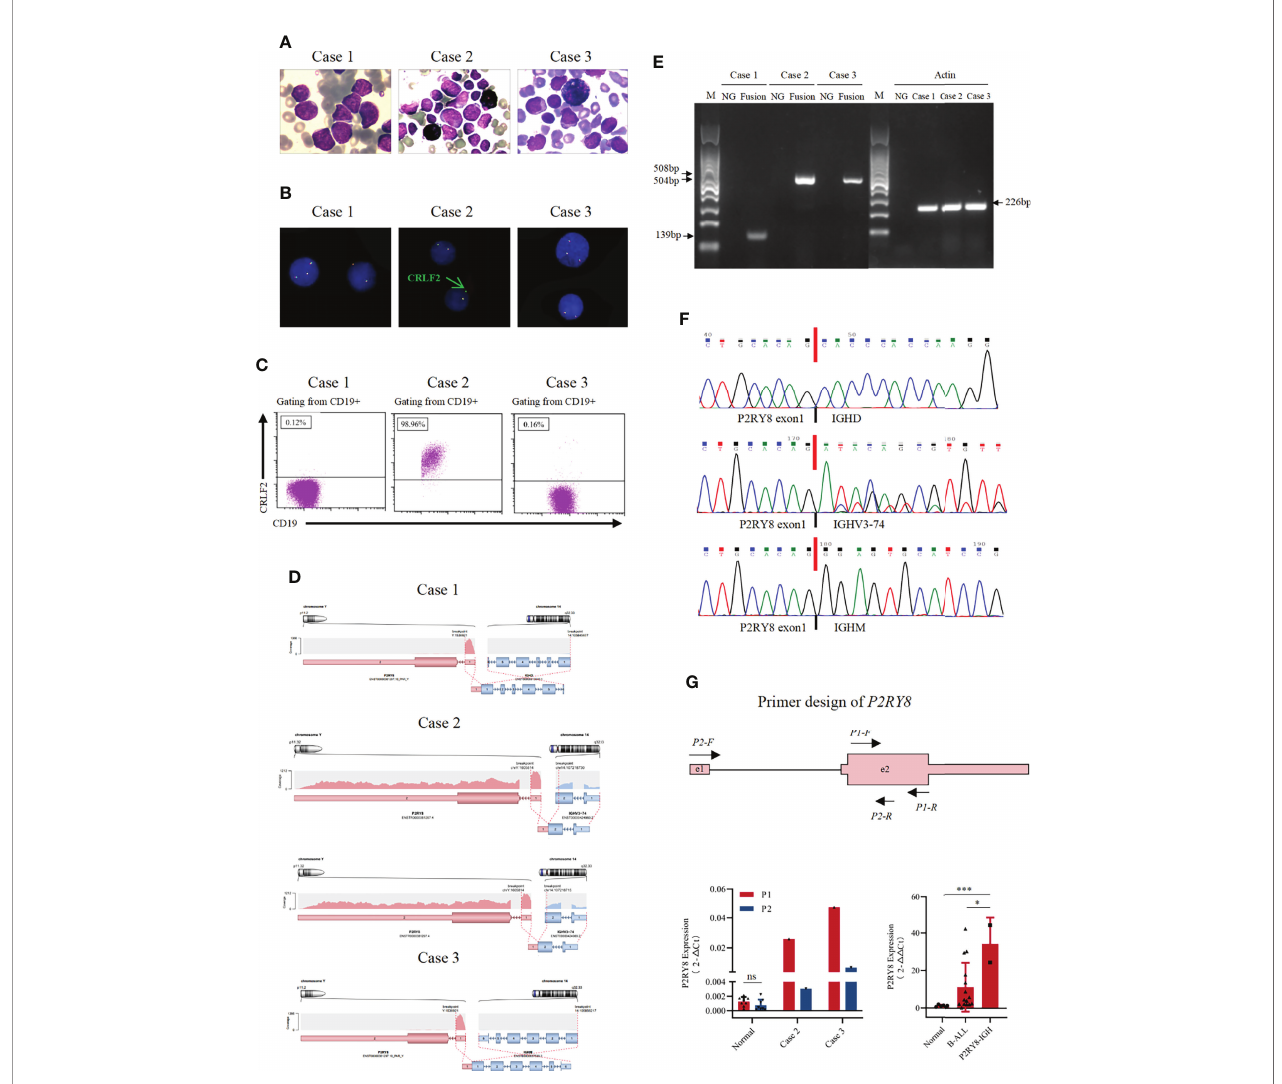
FIGURE 1 | Identi fi cation of novel recurrent P2RY8/IGH fusions. (A) Bone marrow aspirate at diagnosis or relapse (Wright ’ s staining ×1,000). (B) Fluorescence in situ hybridization results with a CRLF2 break-apart probe, which detected split signals of CRLF2 . (C) Immunophenotyping of bone marrow cells at diagnosis or relapse. Flow cytometric analyses of leukemic cells revealed that the blast cells in Case 2 were positive for CRLF2 . (D) RNA sequencing analysis revealed one breakpoint in exon 1 of the P2RY8 gene and breakpoints in different exons of the IGH gene in three patients. (E) A 139 bp product for Case 1 and a 508 bp product for Case 2 were detected by RT – PCR in samples taken at diagnosis. A product of 504 bp for Case 3 was detected by RT – PCR in samples taken at relapse. (F) Sequence alignment of the ampli fi ed product revealed breakpoints between exon 1 of the P2RY8 gene and different exons of the IGH gene at diagnosis or relapse. (G) Structure of the primers designed for the RT – qPCR of P2RY8 . The amount of P2RY8 mRNA in BMNC cell fractions puri fi ed from P2RY8-IGH patients, healthy volunteers (normal) and B-ALL patients was determined by real-time RT – PCR analysis. Each fold change was calculated by the 2^(- △ Ct) method (left) and 2^(- △△ Ct) method (right). Values are